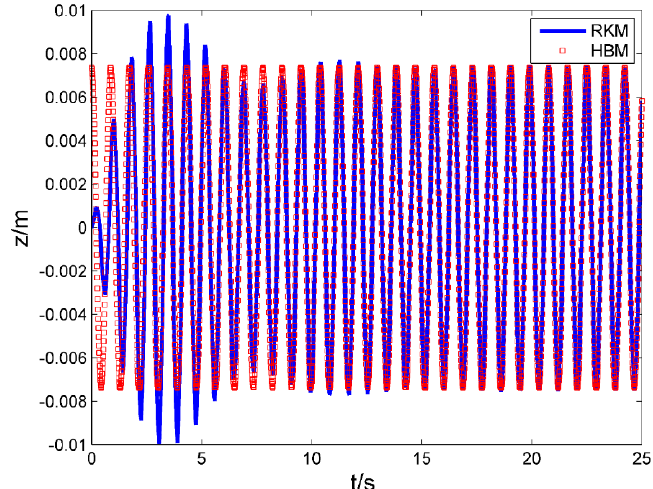
Figure 9. Comparison of numerical and analytical methods of vibration isolation system.